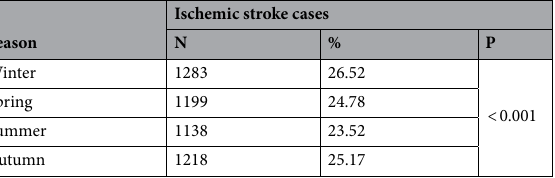
Table 2. Seasonal variation in the frequency of ischemic stroke in the study population. Spring—months from March to the end of May, Summer—June to the end of August, Autumn—September to the end of November, Winter—December to the end of February.